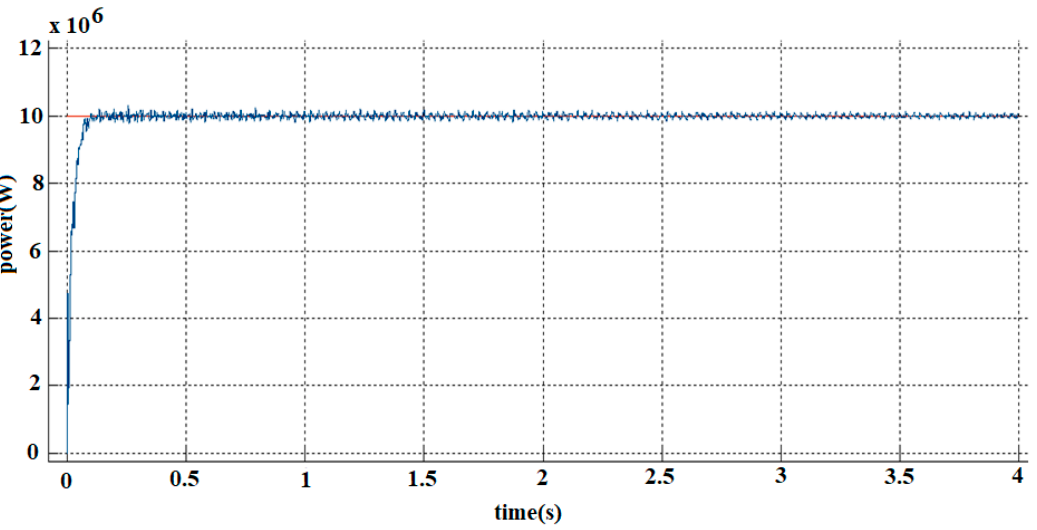
Figure 13. Active and reactive power waveforms of hexverter.